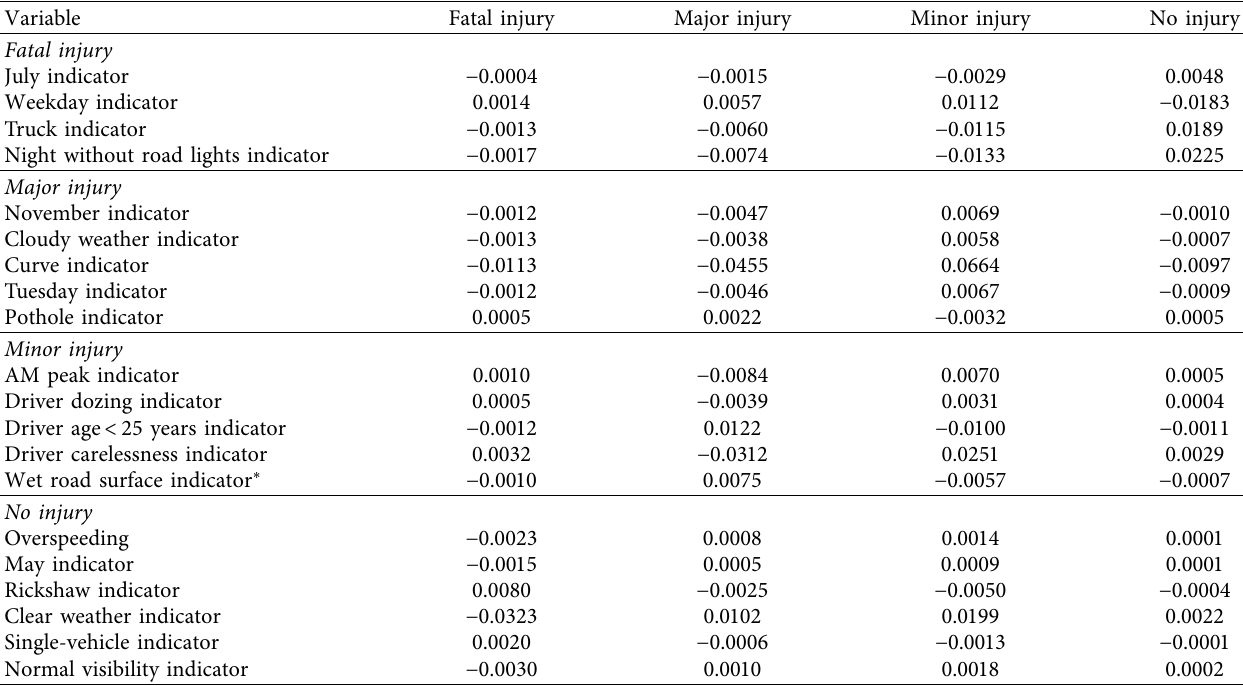
Table 3: Estimated marginal effects of the model.